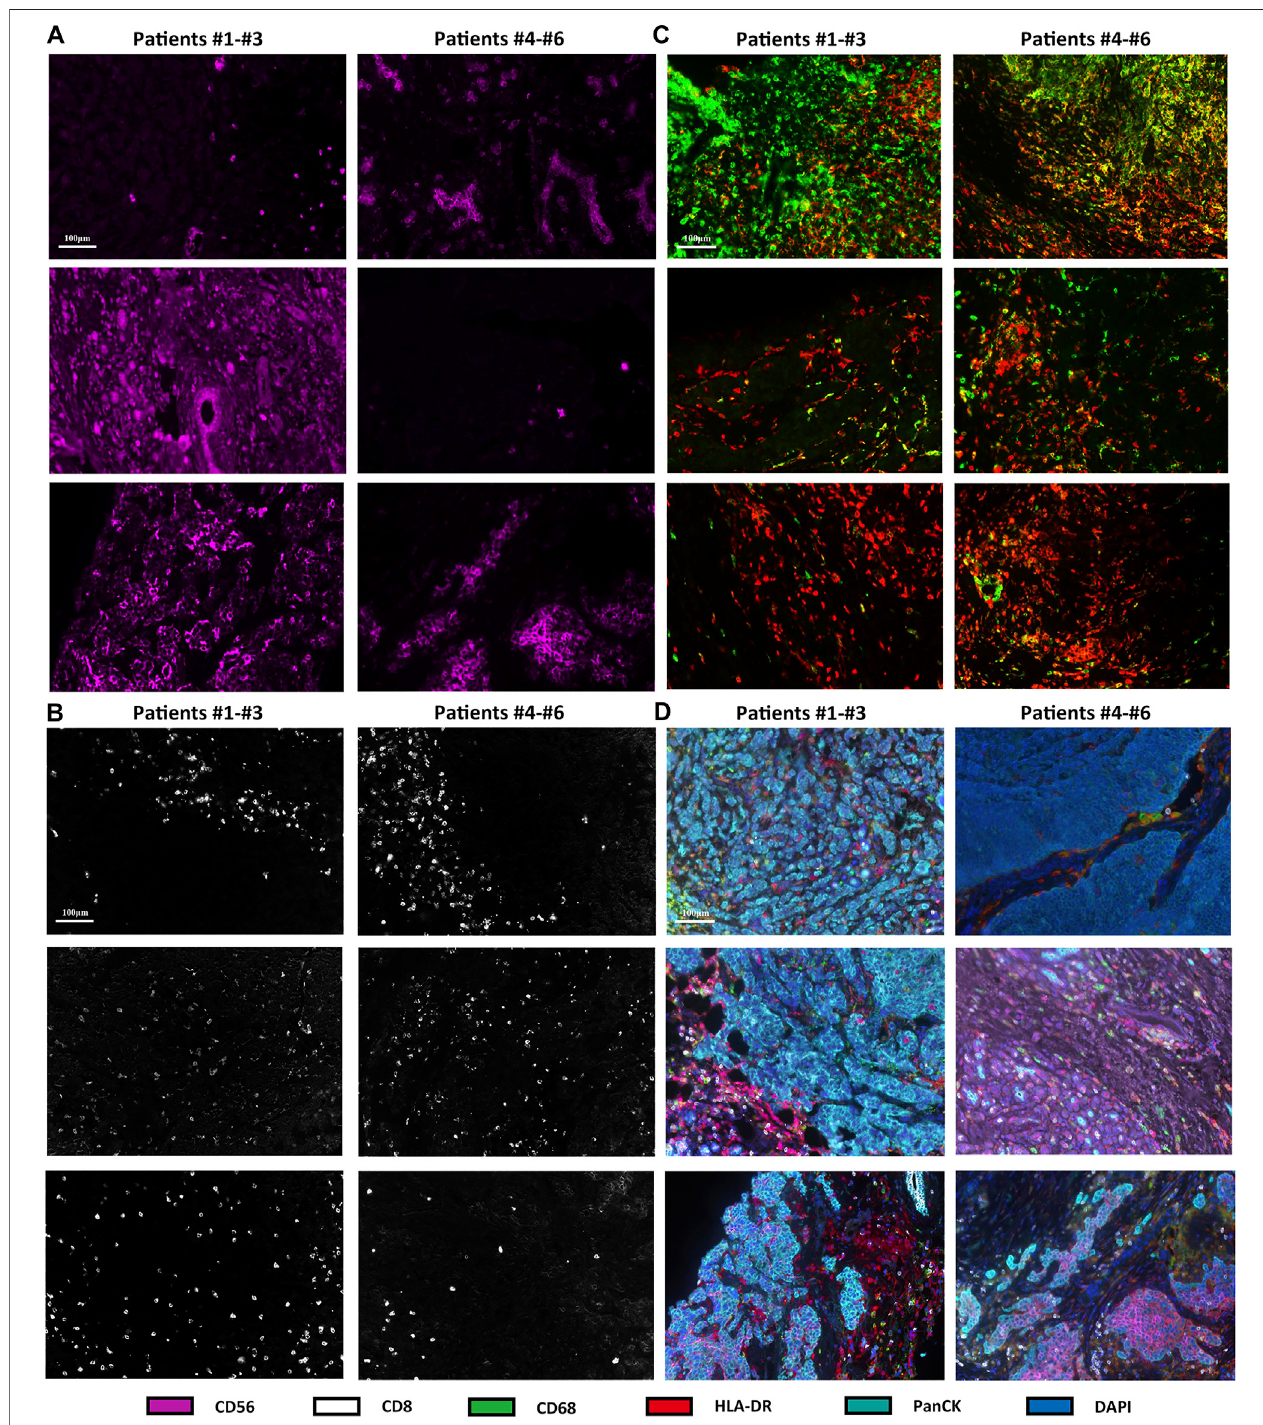
FIGURE 3 | mIHC/IF results of different immune cell subtypes from six TNBC patients received NAC. The fl uorescence staining of CD56 (A) , CD8 (B) , CD68, and HLA-DR (C) . (D) mIHC/IF staining results of CD56, CD8, CD68, HLA-DR, PanCK, and DAPI.